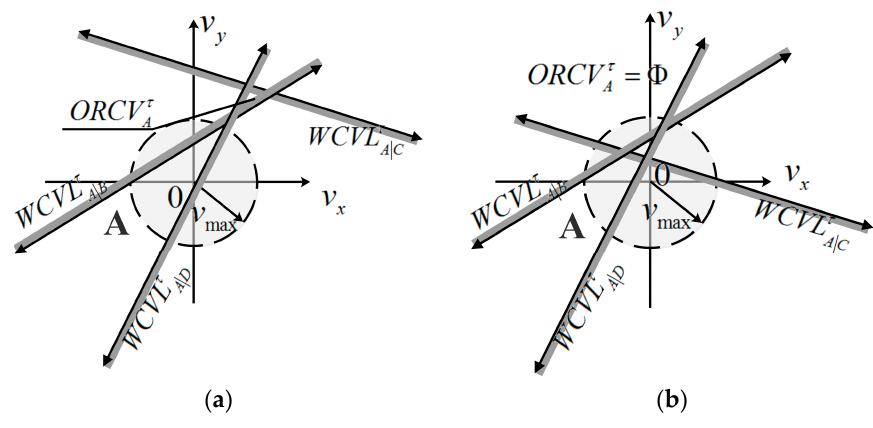
Figure 10. Two situations of null set. ( a ) ORCV τ